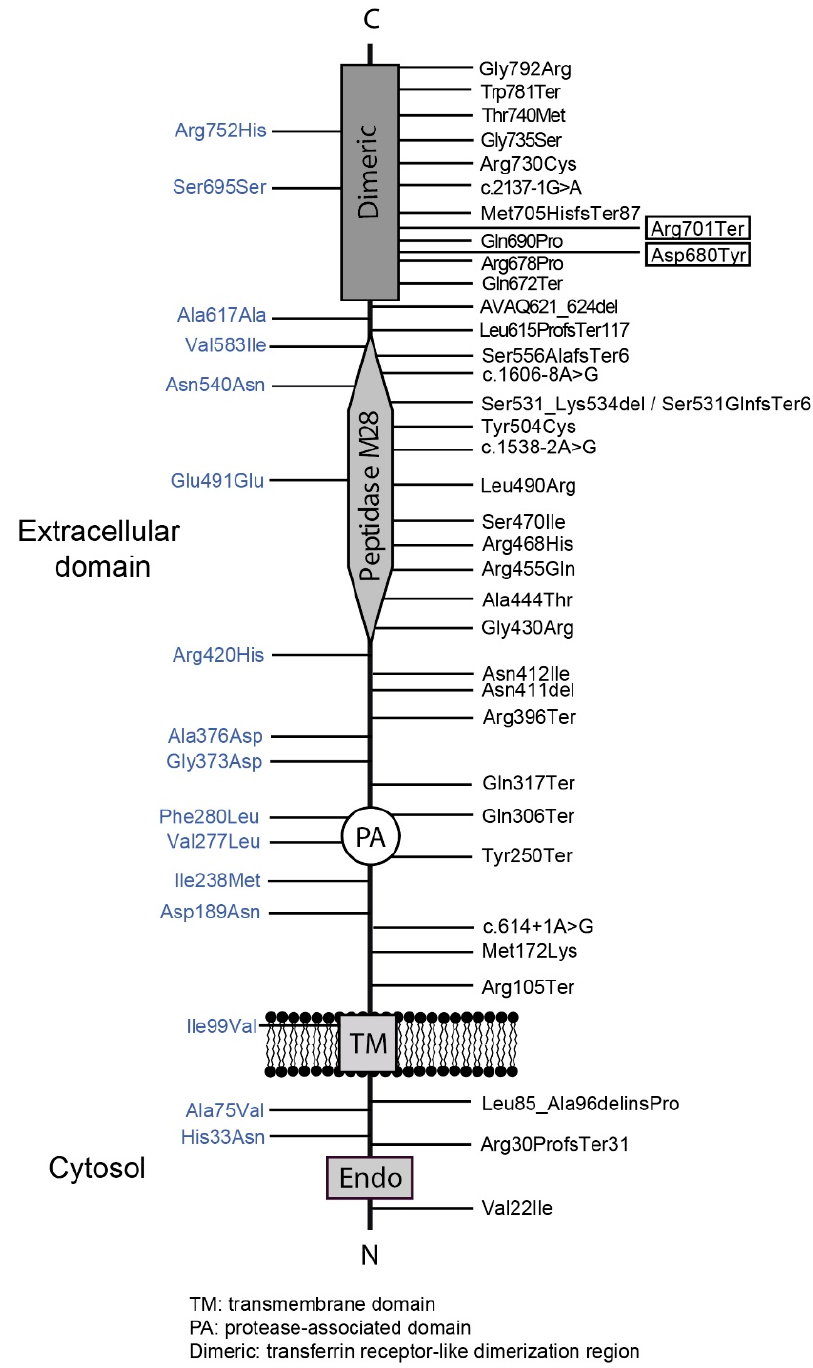
Figure 3. Localization of the reported mutations in the TFR2 protein. The new mutations reported are boxed. Dimeric , Transferrin Receptor-like dimerization region; TM , transmembrane domain; PA , Protease-Associated domain. Image adapted from Joshi et al. [23]. Here, we describe six patients with non-HFE related HH from five unrelated families TFR2 gene.